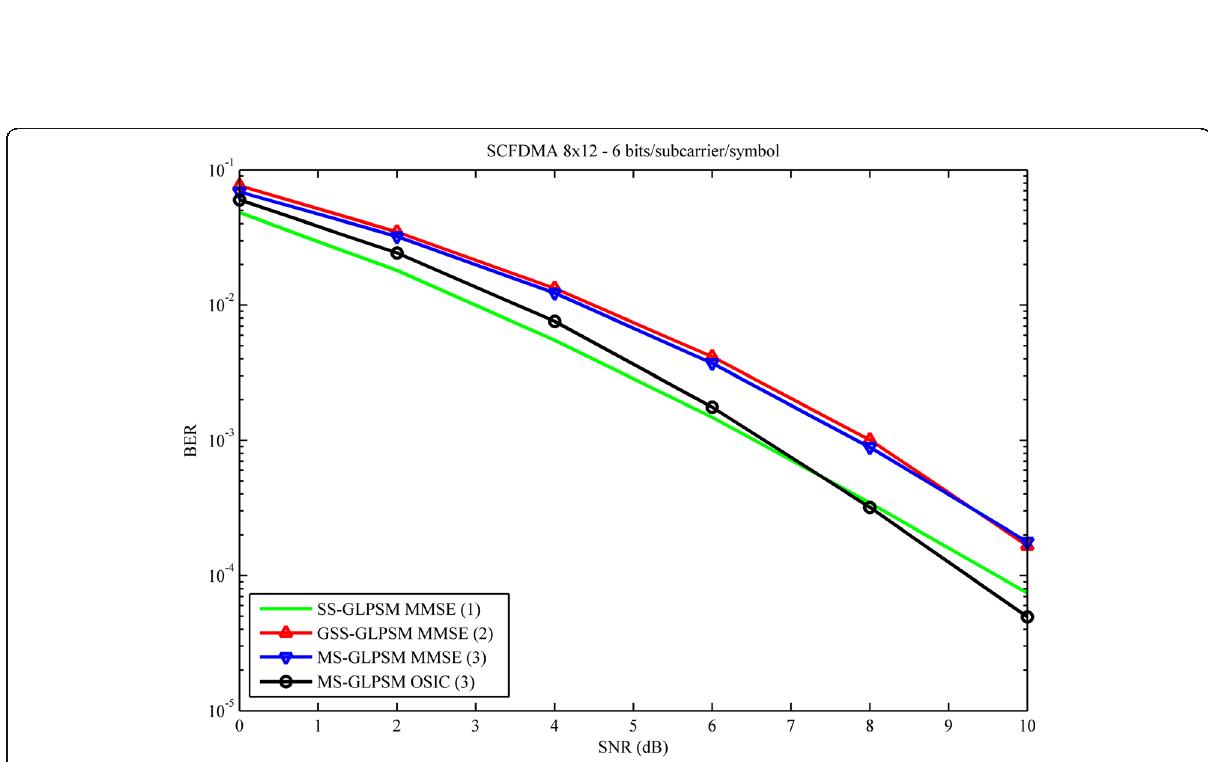
Fig. 7 Performance comparison for SC-FDMA GLPSM techniques with the parameters given in Table 2. This performance comparison is given for lower over datarate of 6 bits/subcarrier/symbol. Because of that, V-BLAST is omitted and only the proposed techniques are compared. For MS- GLPSM, MMSE and OSIC receiver are compared. 8 × 12 MIMO in EPA-5 is